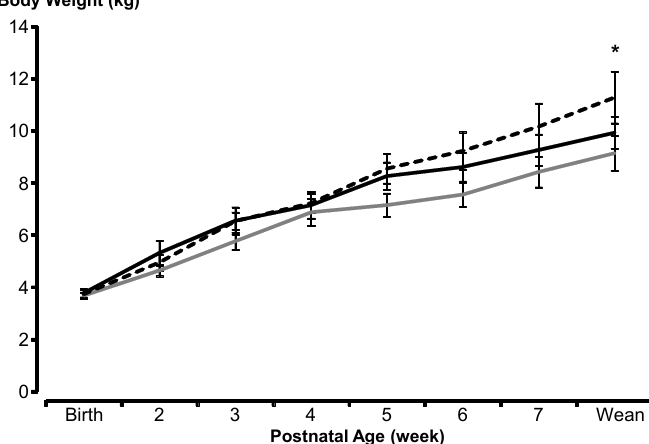
Figure 4. Body weight ( ± SEM) from birth to weaning (Week 8) in the progeny of Rambouillet ewes that received alfalfa (Control; grey line), Opuntia (black solid line), or protein-enriched Opuntia (black dotted line) during late gestation. The data are combined for birth type (singleton and twins) and sexes.